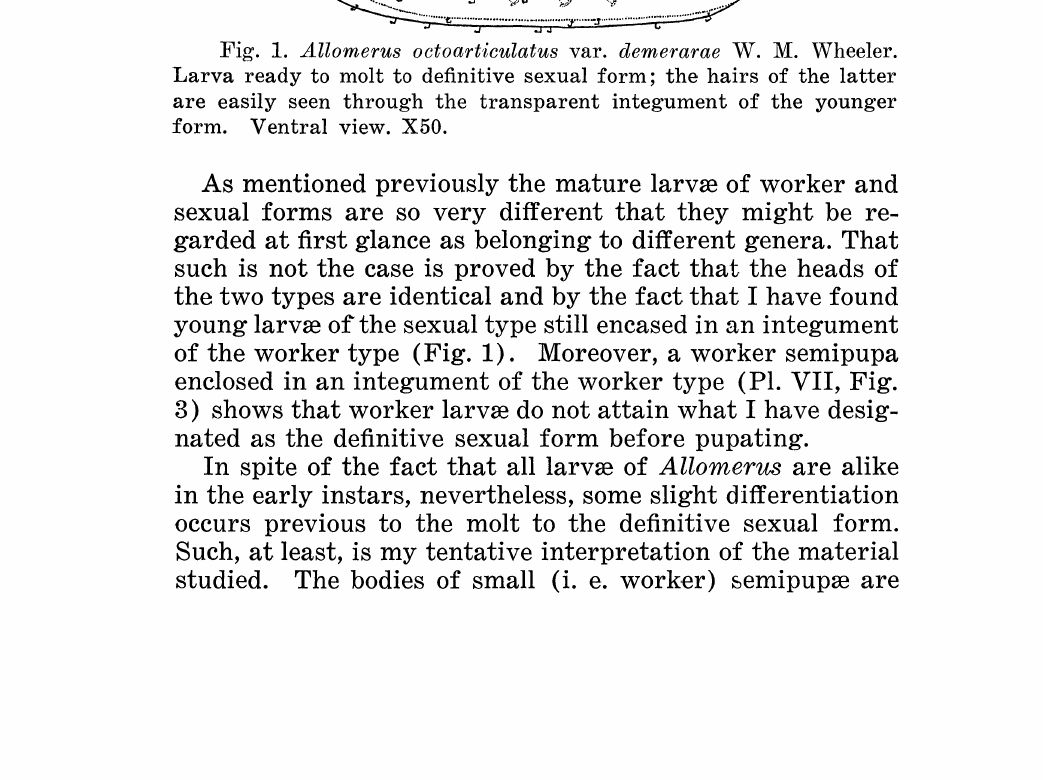
Fig. 1. Allomerus octoarticulatus var. demerarae W. M. Wheeler. Larva ready to molt to definitive sexual form; the hairs of the latter are easily seen through the transparent integument oi the younger form. Ventral view.